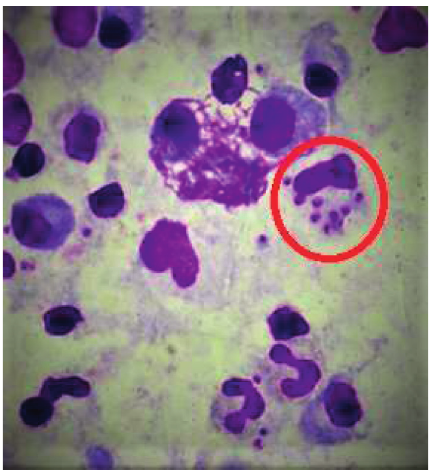
Figure 4: Giemsa-stained smear shows the typical presence of amastigote forms of Leishmania